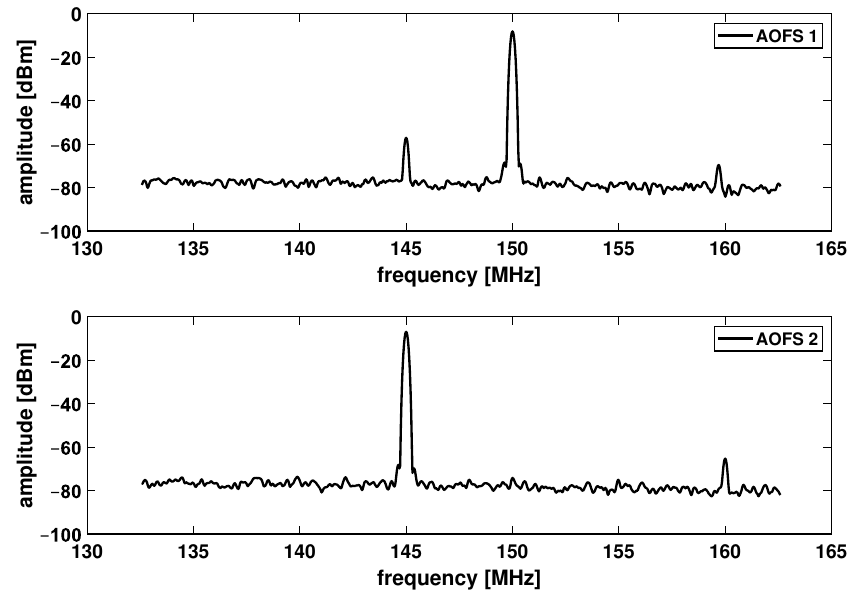
Figure 5. Spectra of RF driving signals for both AOFS. The frequency interval between this sideband and the main peak equals to the heterodyne frequency, leading to a ghost signal of unstable phase responsible for the non-linear OPD